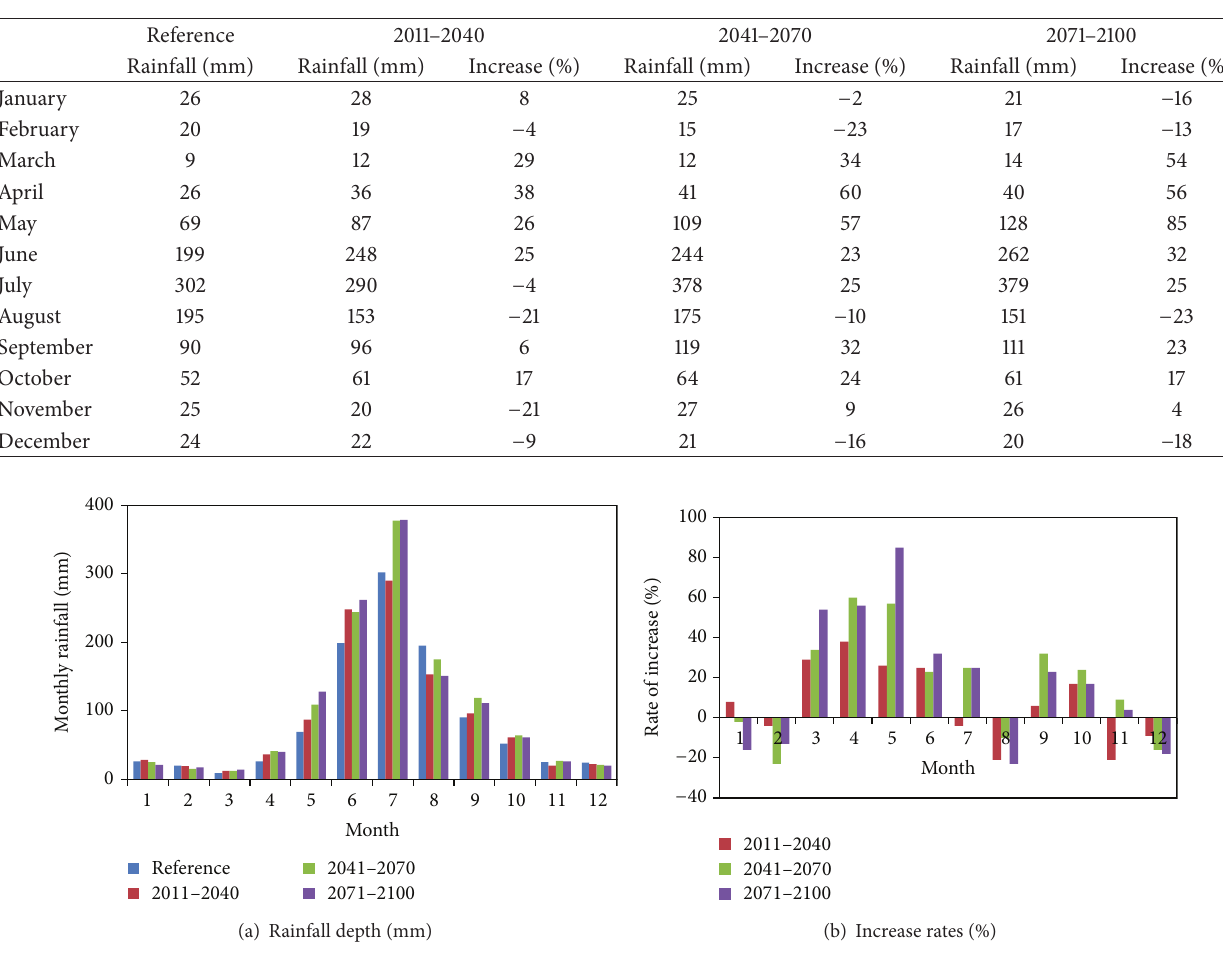
Table 4: Change of monthly rainfall in each target period.